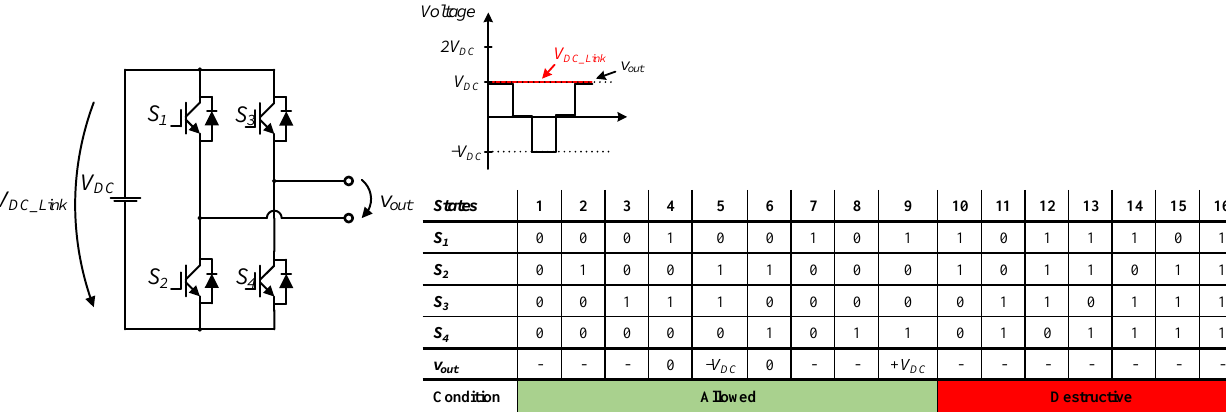
Figure 4. Half-bridge with single DC bus topology and operation principle.